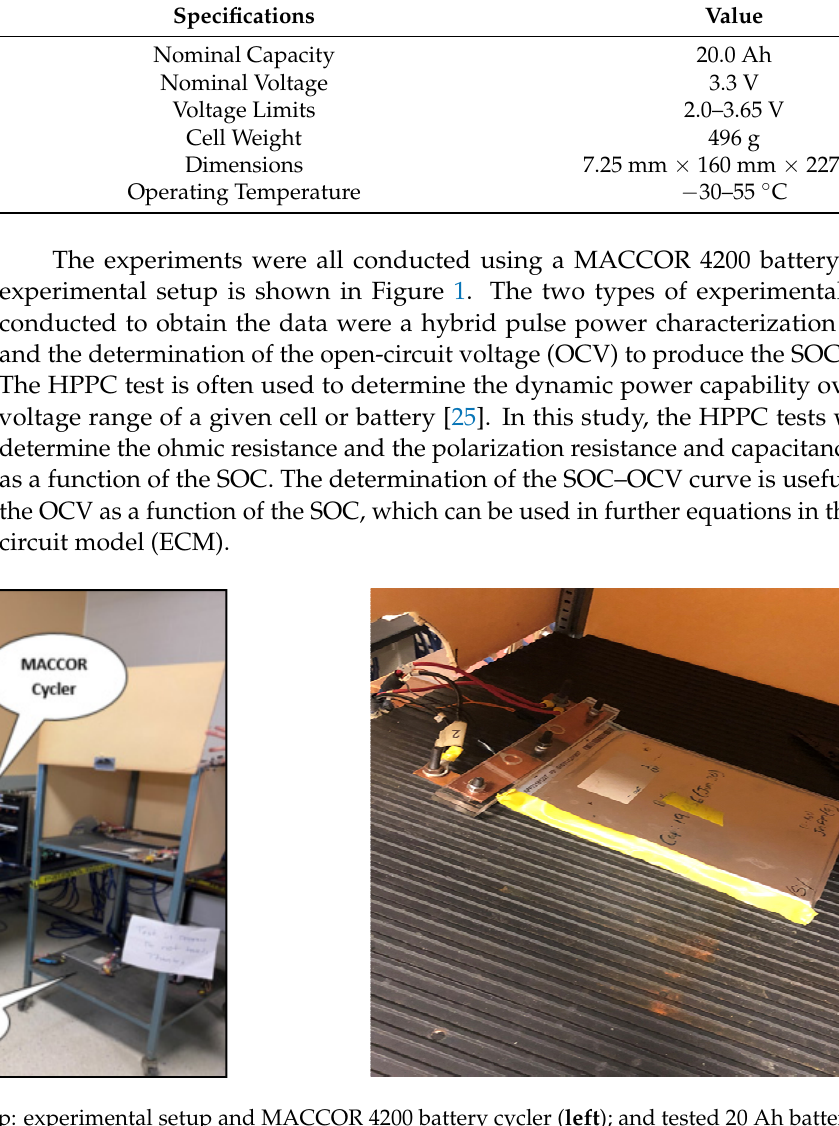
Figure 1. Experimental setup: experimental setup and MACCOR 4200 battery cycler ( left ); and tested 20 Ah battery pouch cells ( right